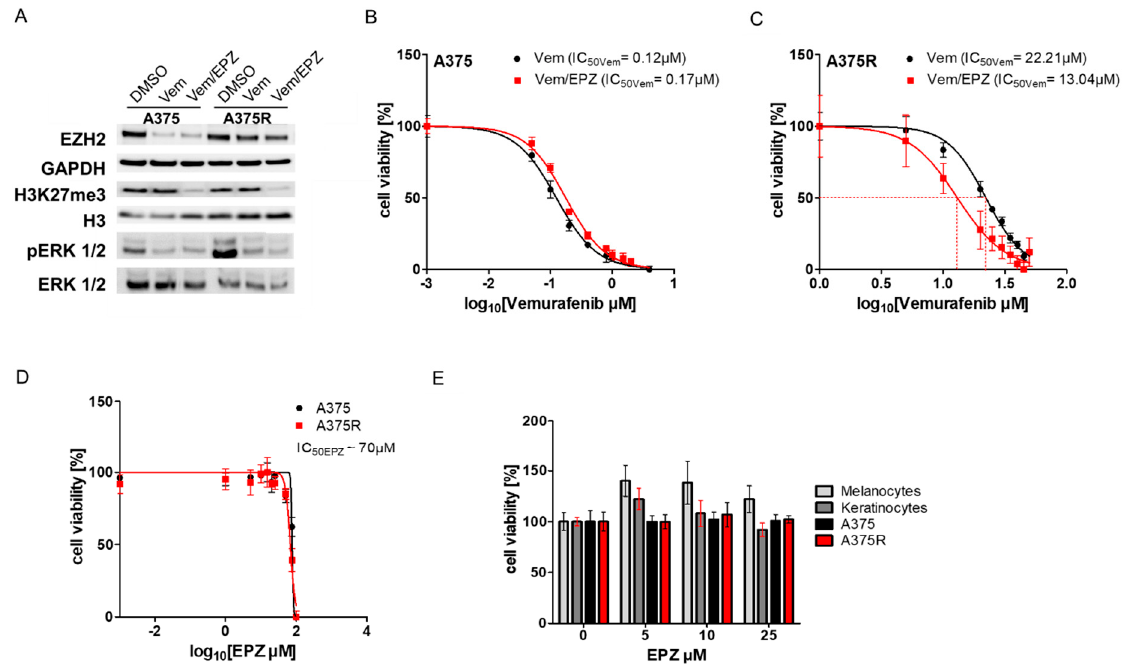
Figure 1. Inhibition of EZH2 improves response to vemurafenib in resistant cell lines. ( A ) Western blot of susceptible cells (A375) and cells resistant to vemurafenib (A375R), treated with DMSO (control), vemurafenib (Vem; A375 1 µM, A375R 10 µM) or vemurafenib and tazemetostat (EPZ; 5 µM), investigated EZH2, GAPDH, H3K27me3, H3, pERK 1/2 and ERK 1/2. Viability analyses of ( B ) A375 cells and ( C ) A375R cells treated with increasing concentrations of vemurafenib monotherapy (A375 0-4 µM; A375R 0-50 µM) or in combination with EPZ (5 µM). Cell viability of ( D ) A375 cells and A375R cells as well as ( E ) normal melanocytes and normal keratinocytes treated with increasing concentrations of EPZ (0-100 µM).